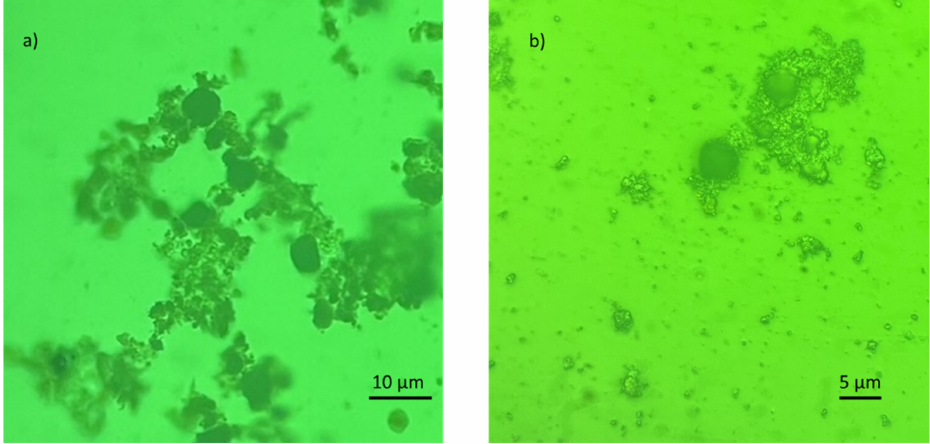
Figure 10. Auxenochlorella protothecoides cells with adsorbed Fe 3 O 4 -PEI nanocomposites at different magnifications ( a , b